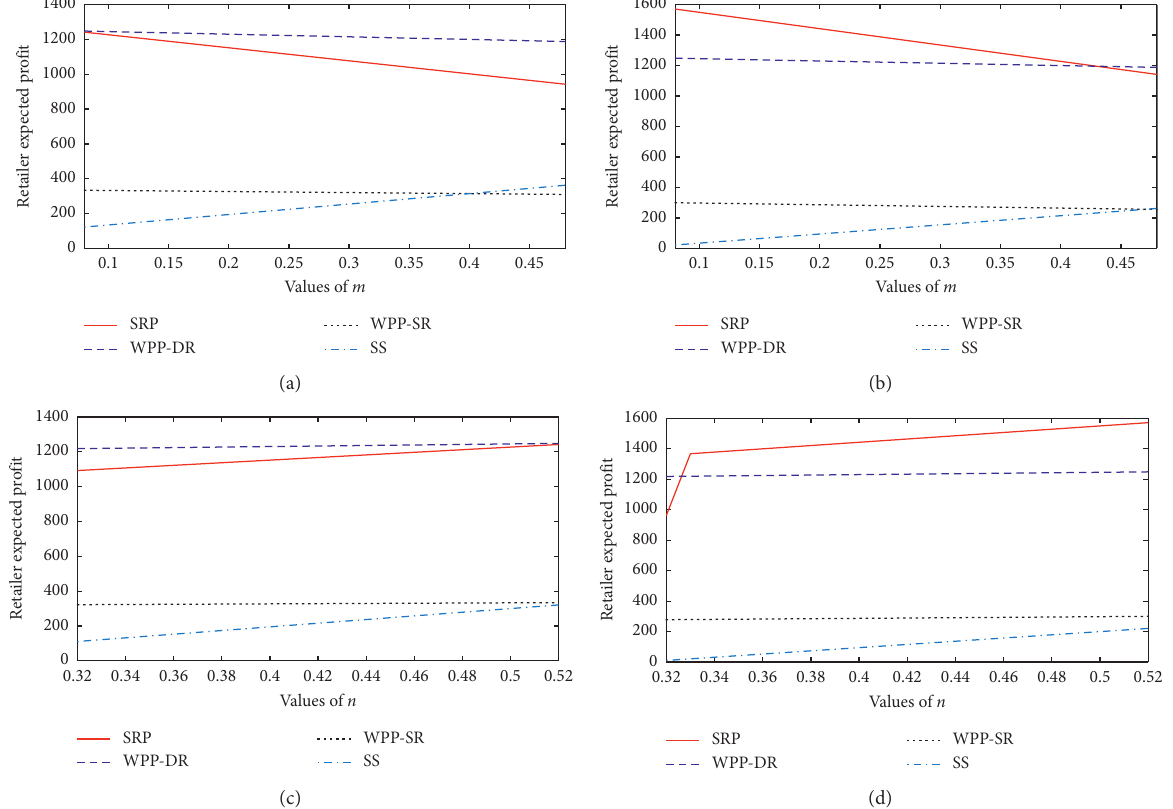
Figure 3: The retailer’s expected profit under different values of m and n .